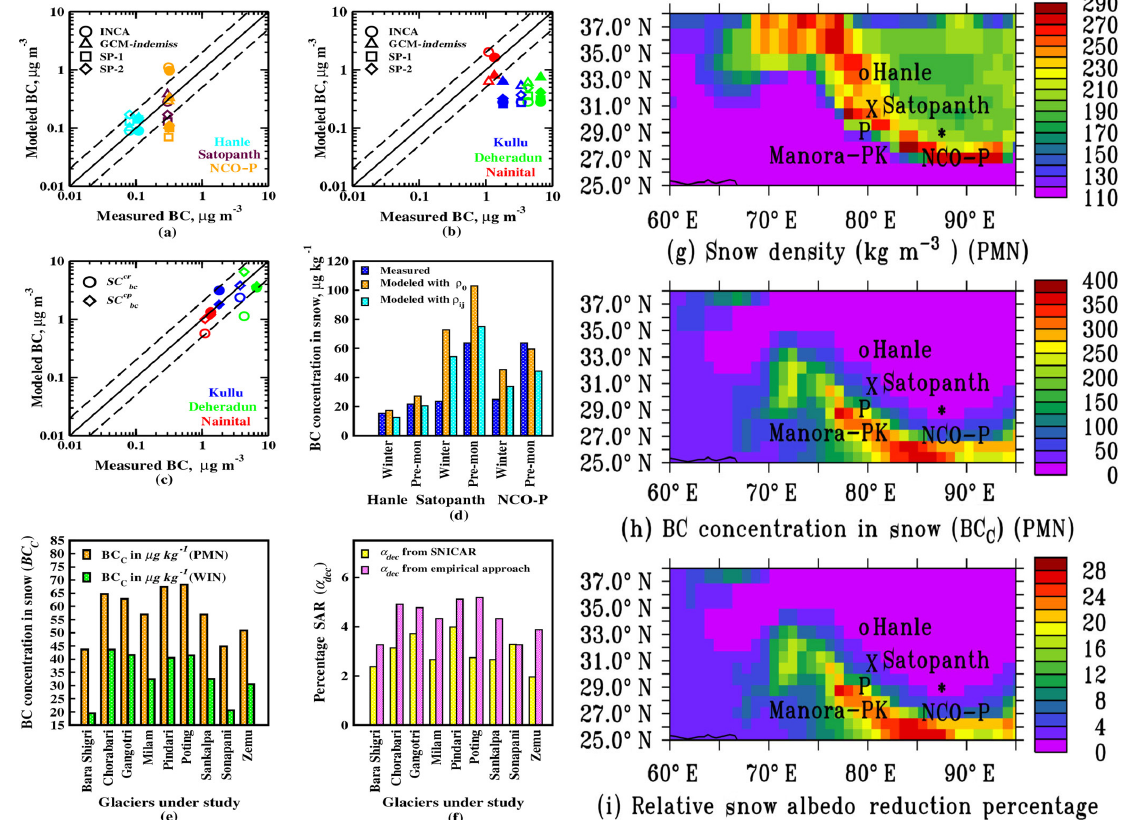
Figure 2. Figures showing spatio-seasonal variation of atmospheric mass BC concentration for pre-monsoon (filled symbols) and winter (unfilled symbols) for (a) higher altitude stations, (b) lower altitude stations, (c) modeled versus measured atmospheric BC concentration at lower altitudes using RA and PA, (d) stationwise BC concentration in snow (BC c ) and comparison of modeled and measured values for higher altitudes, (e) Glacierwise value of BC c considering only dry deposition for winter and pre-monsoon season, and (f) glacierwise percentage snow albedo reduction (SAR) from both SNICAR and the empirical approach for pre-monsoon; and spatial distribution of (g) averaged snow density from ECMWF for pre-monsoon season (PMN), (h) average of the modeled BC c for PMN, and (i) percentage SAR estimated using empirical approach ( α empirical ) for dec